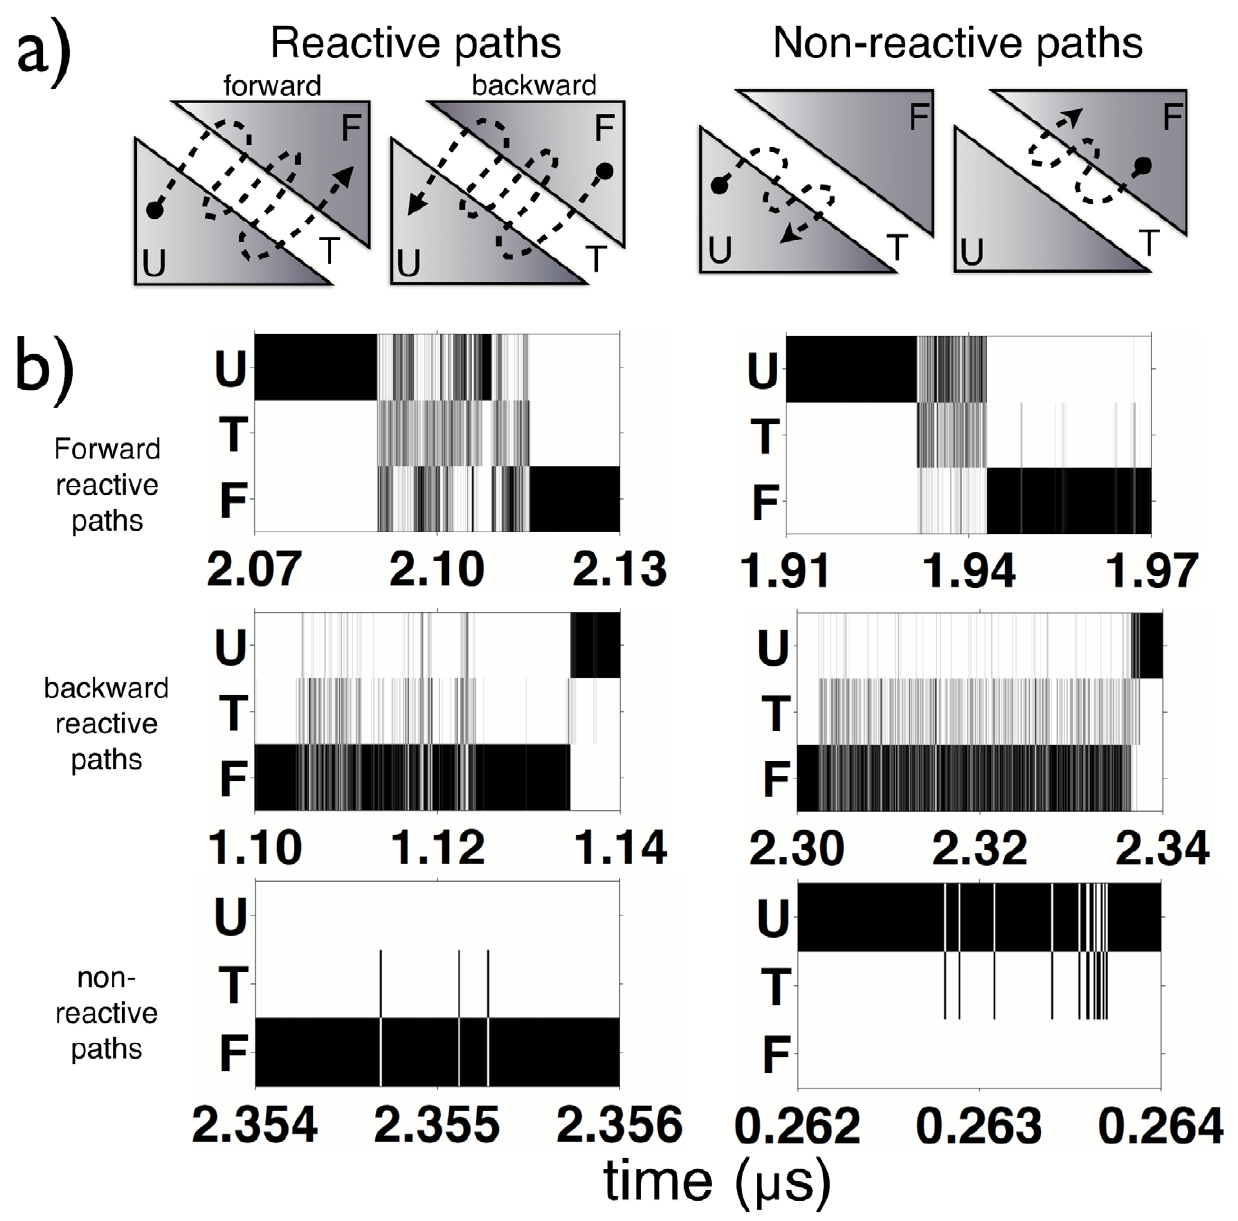
Figure 3. Scenarios for the path reaching and crossing the TS. a) Schematic diagram showing the possible scenarios for the paths reaching the TS, namely: reactive and non-reactive paths; in the reactive paths, the crossing of the TS can occur either from U to F (forward reactive path) or from F to U (backward reactive path); in non-reactive paths, the peptide falls back into the state of origin (either U ? TS ? U or F ? TS ? F paths). b) Time evolution of the peptide through the U, TS and F states for six representative paths along the simulations. The three rows in each panel represent the existence of the U (unfolded), T (transition) and F (folded) states. All the four scenarios described in panel a can be observed. The top and middle panels show the forward and backward reactive paths, respectively. The bottom panels show the non-reactive paths, either U ? TS ? U